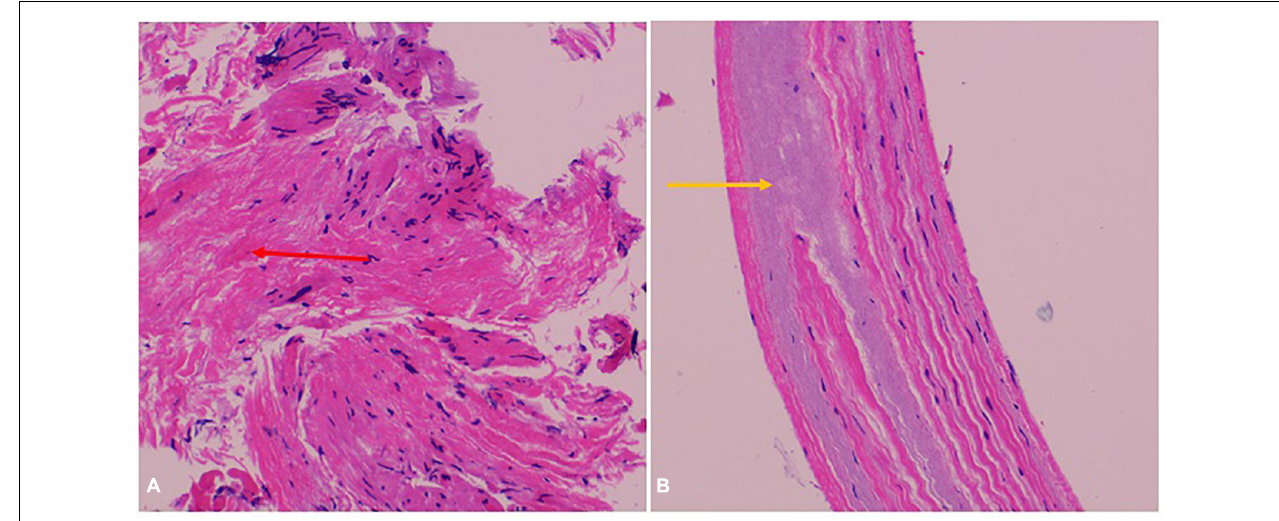
FIGURE 5 | Myocardial biopsy pathological result. (A) Hyaline degeneration within the collagen fibers (red arrow). (B) Blurred stripes in some myocardial fibers with mucoid degeneration among parallel collagenous fibers (yellow arrow).